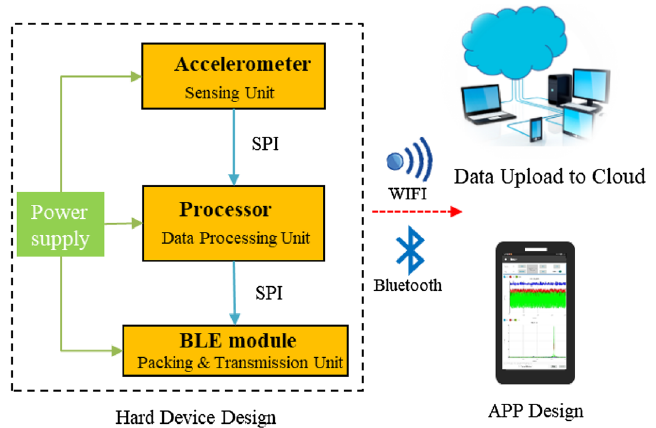
Figure 1. Schematic of the ORS